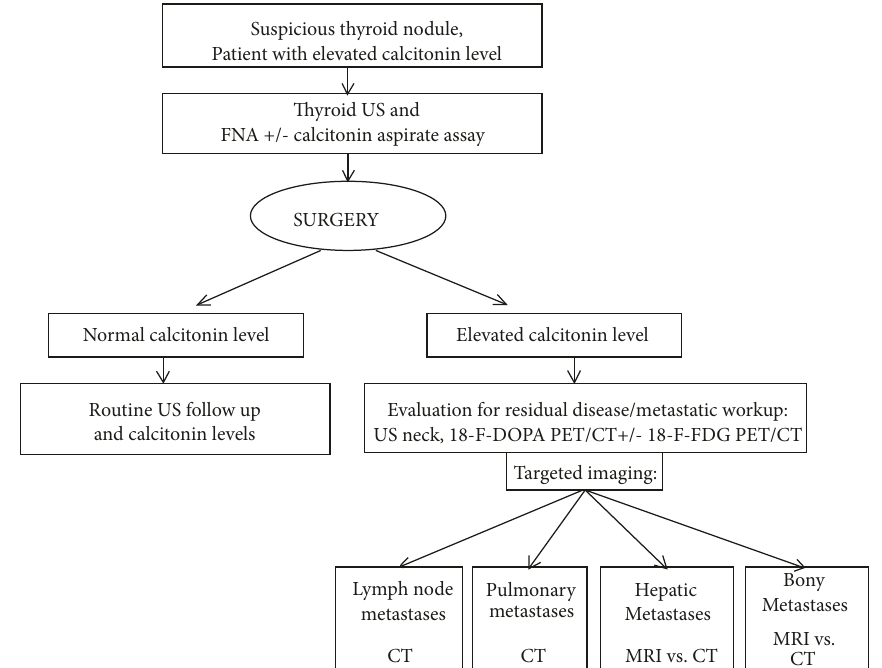
Figure 5: The proposed management approach for patients with medullary thyroid carcinoma. Please see explanations in the